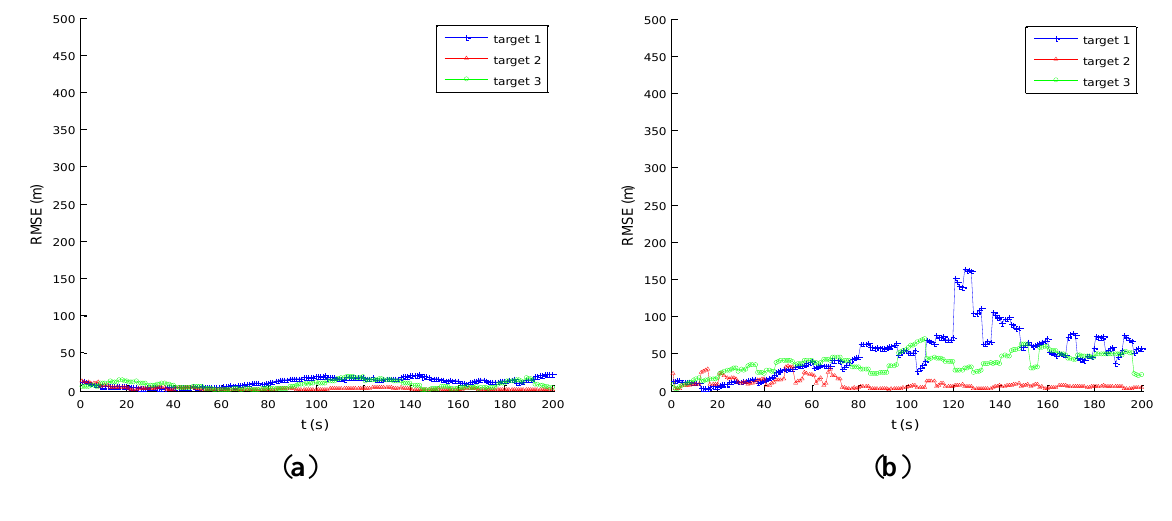
Figure 9. RMSE of position for less challenging